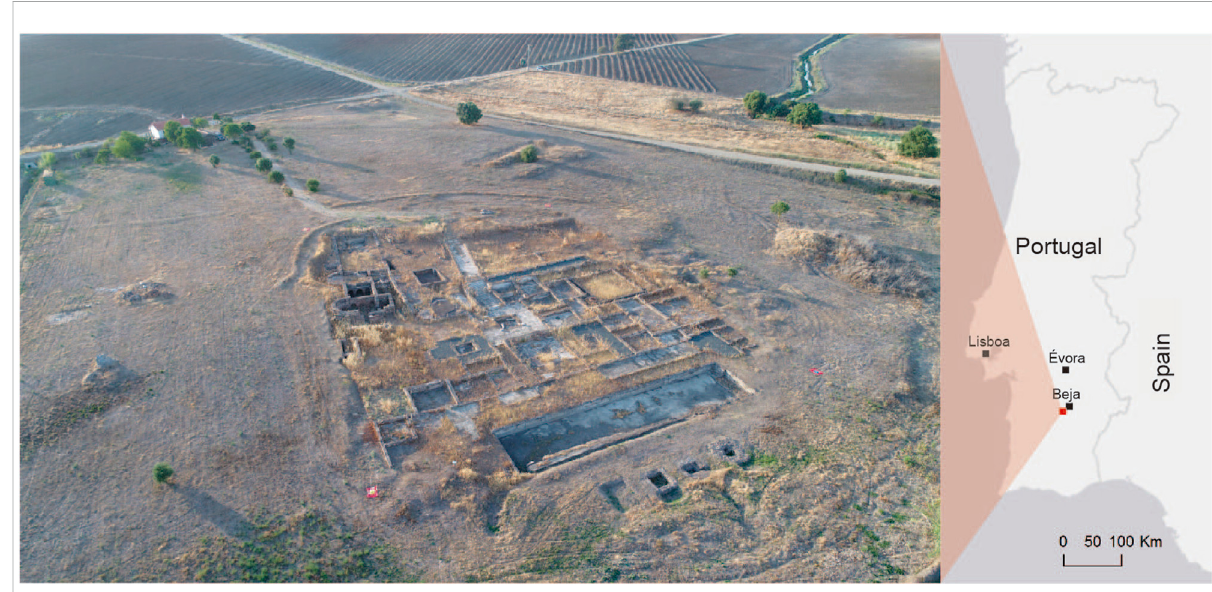
FIGURE 1 Geographical location and general view of the Roman Villa of Pisões (image obtained by an unmanned aerial vehicle). The exposed structures are the remains of the pars urbana of the